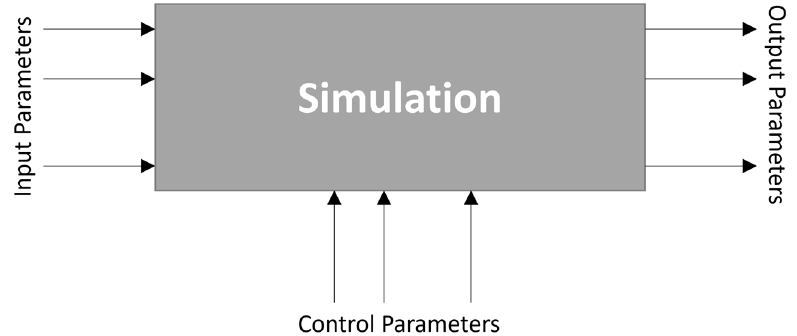
Figure 2. Structure of Simulation-based Optimization.